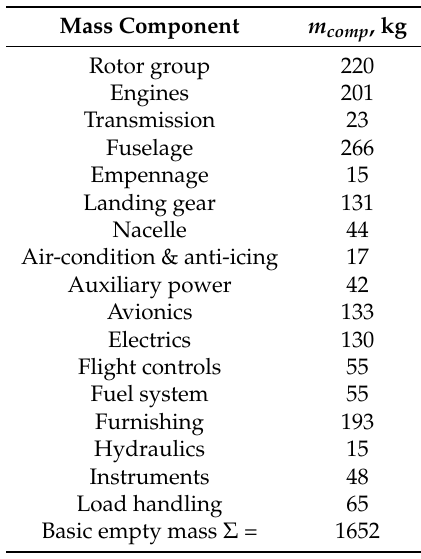
Table 6. Breakdown of the component masses for the virtual